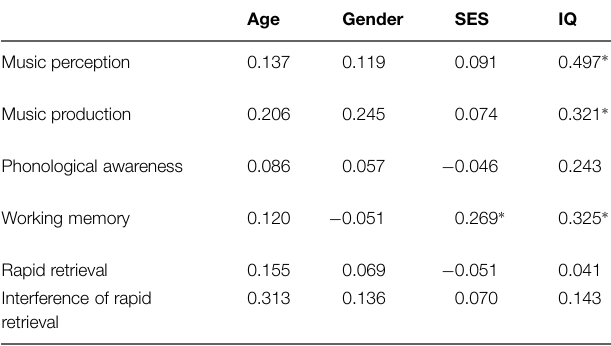
TABLE 1 | Correlations among possible confounding variables [age, gender, socioeconomic status (SES), and IQ], musical abilities (music perception and music production), and precursors of reading (phonological awareness, working memory, and rapid retrieval from long-term